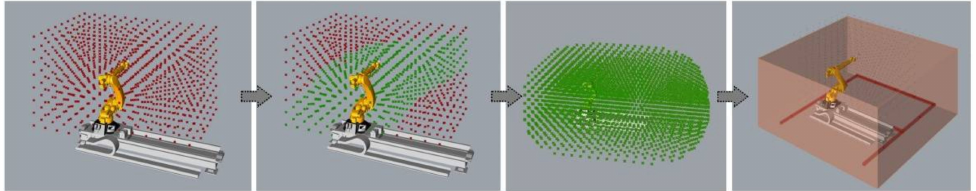
Figure 6. The process of determining the operable range of a